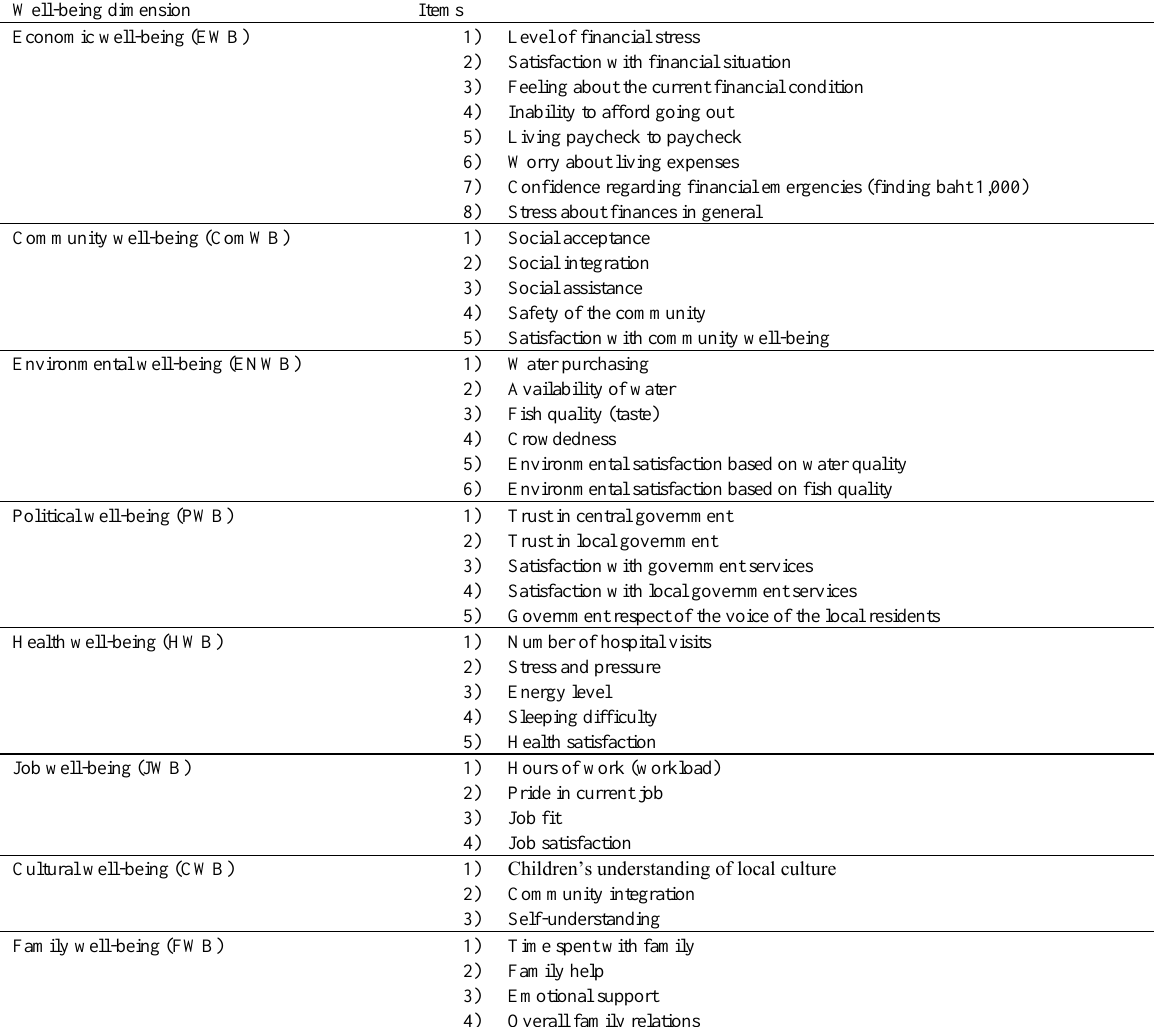
Table 1: Well-being